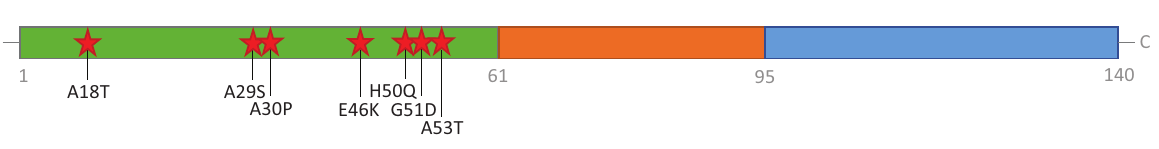
Figure 1. Location of disease-associated point mutations in (cid:2)-synuclein, indicated by red stars. Increased expression of wildtype (cid:2)-synuclein also increases formation of (cid:2)-synuclein oligomers and fibrils, likely due to levels of (cid:2)-synuclein exceeding the ability of cells to maintain proteostasis by chaperoning or degradation [5]. Some sporadic cases of PD may originate from increased expression of (cid:2)-synuclein. GWAS studies have correlated polymorphisms in the SNCA gene with increased risk to PD, including the “Rep1” variant in the SNCA promoter [22]. Epigenetic changes can also enhance SNCA expression, including reduced CpG methylation of the SNCA intron 1, discovered in sporadic PD brains